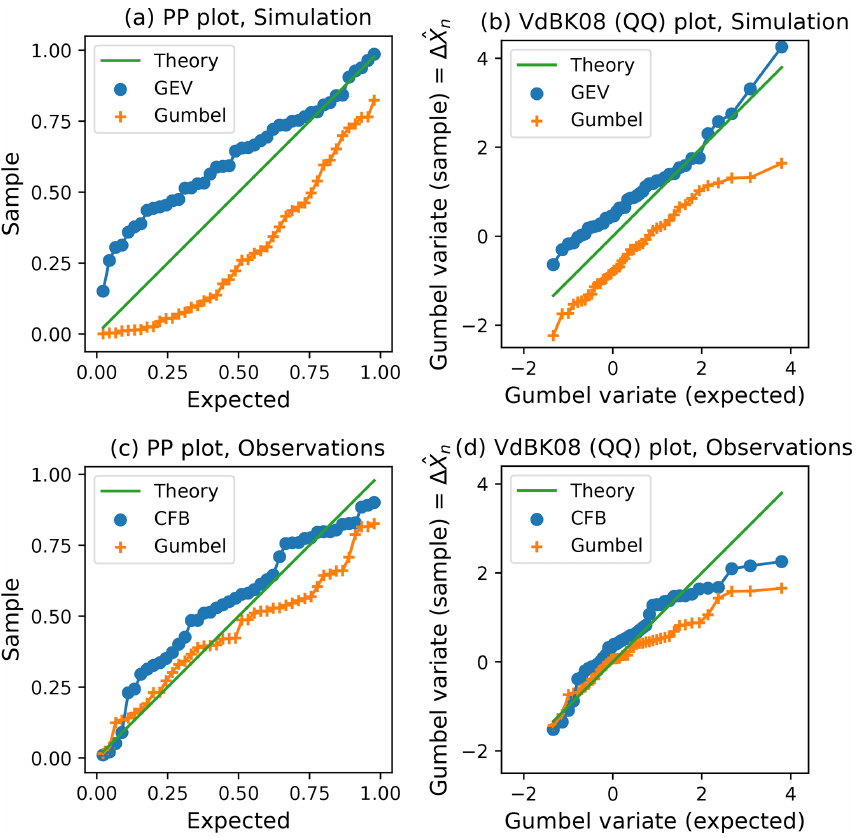
Figure 3. Panels (a) and (c) show P–P plots as described above, and (b) and (d) show plots following VdBK08, for skew surge at 44 sites of UK tide gauges (one plotted point per gauge). Orange cross symbols relate to a Gumbel fit to annual maxima. Blue circles relate to unconstrained GEV fits to annual maxima (simulation, a , b ) and constrained GPD fits to peaks over a threshold following the CFB2018 guidance (Environment Agency, 2018) method (observations, c , d ). Each point represents an outlier (the largest annual maximum in the record) at a gauge. The y axis of the Q–Q plot is labelled (cid:49) ˆ X n for consistency with